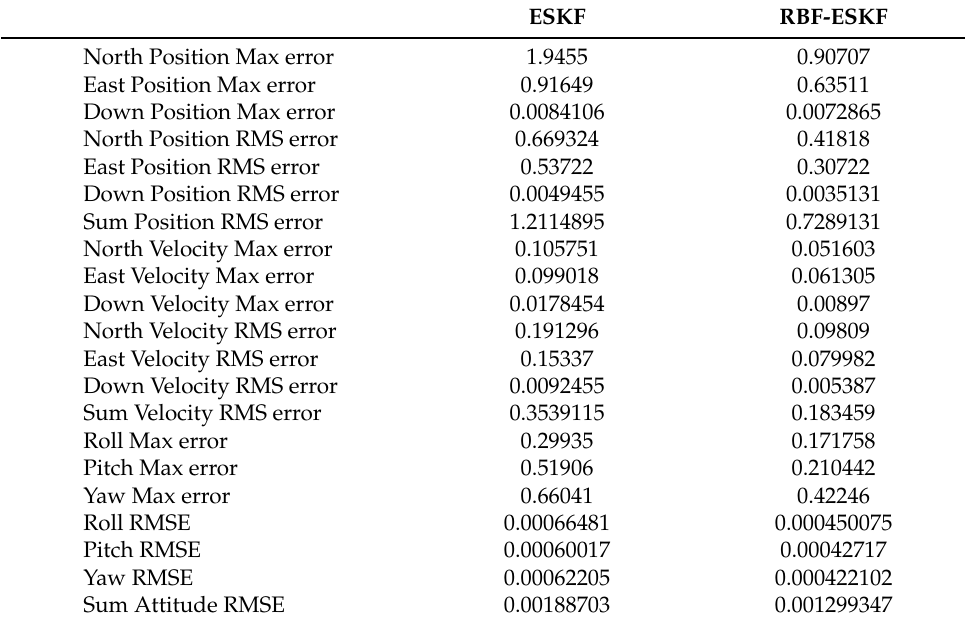
Table 5. Performance comparison of ESKF and RBF-ESKF with the Doppler velocity log (DVL) measurement unavailable for a short duration by running 100 Monte Carlo simulations.